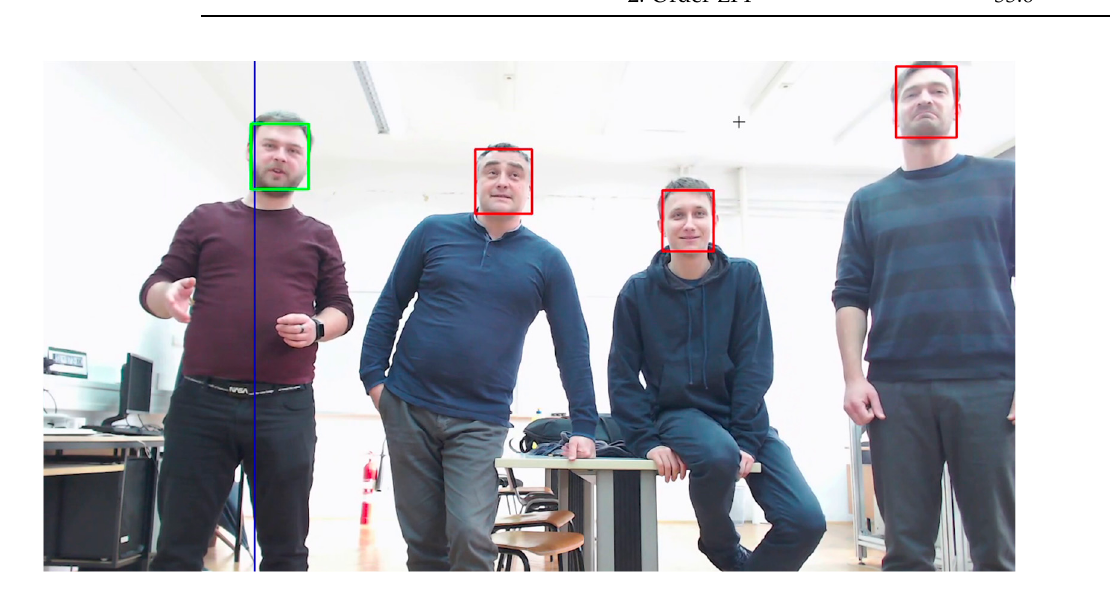
Figure 9. Speaker 1 talking.